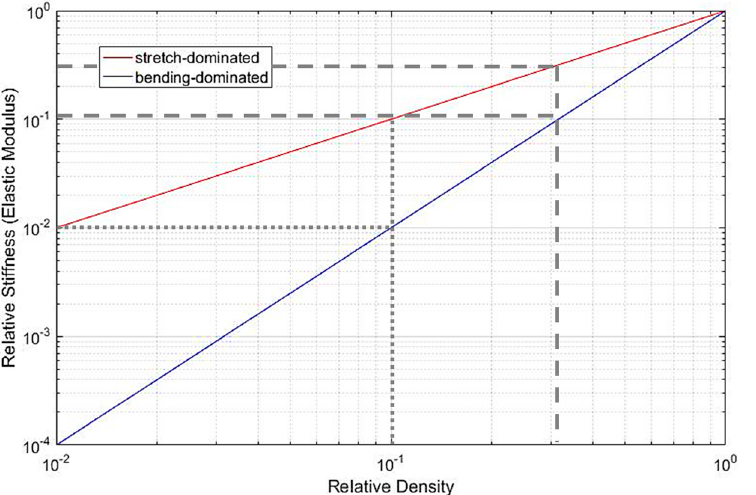
Figure 3. Comparison of the theoretical relationship between relative bulk density and relative stiffness (Compressive modulus) for stretch and bending dominated structures .